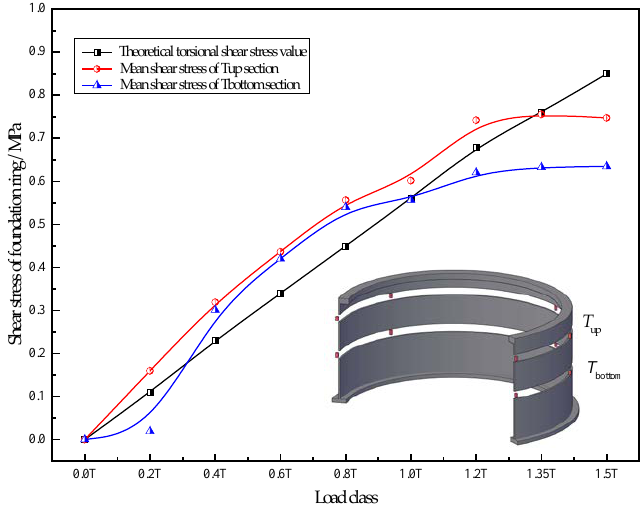
Figure 8. Torsional shear stress in the foundation ring of ZT-1.